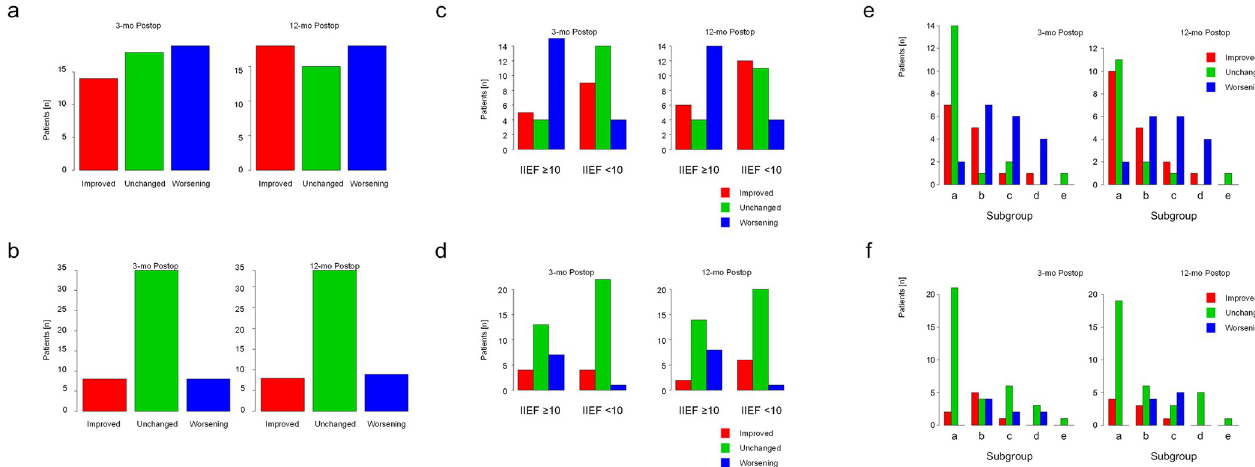
Fig 1. Outcomes according to IIEF-5 score at 3- and 12-month follow-up after TUEB in patients with BPO. (a) Outcomes based on changes in the IIEF-5 score � 1. (b) Outcomes based on changes in the IIEF-5 score � 4. (c) Outcomes based on changes in the IIEF-5 score � 1 in patients with an IIEF-5 score � 10 (group 1, left side of chart) and IIEF-5 score < 10 (group 2, right side of chart). (d) Outcomes based on changes in the IIEF-5 score � 4 in patients with an IIEF- 5 score � 10 (group 1, left side of chart) and an IIEF-5 score < 10 (group 2, right side of chart). (e) Outcomes based on changes in the IIEF-5 score � 1 in patients with an IIEF-5 score 5–7 (subgroup a), IIEF-5 score 8–11 (subgroup b), IIEF-5 score 12–16 (subgroup c), IIEF-5 score 17–21 (subgroup d), and IIEF-5 score 22–25 (subgroup e). (f) Outcomes based on changes in the IIEF-5 score � 4 in patients with IIEF-5 scores as defined in panel (e). BPO: benign prostatic obstruction, IIEF: International Index of Erectile Function, TUEB: transurethral enucleation with bipolar.